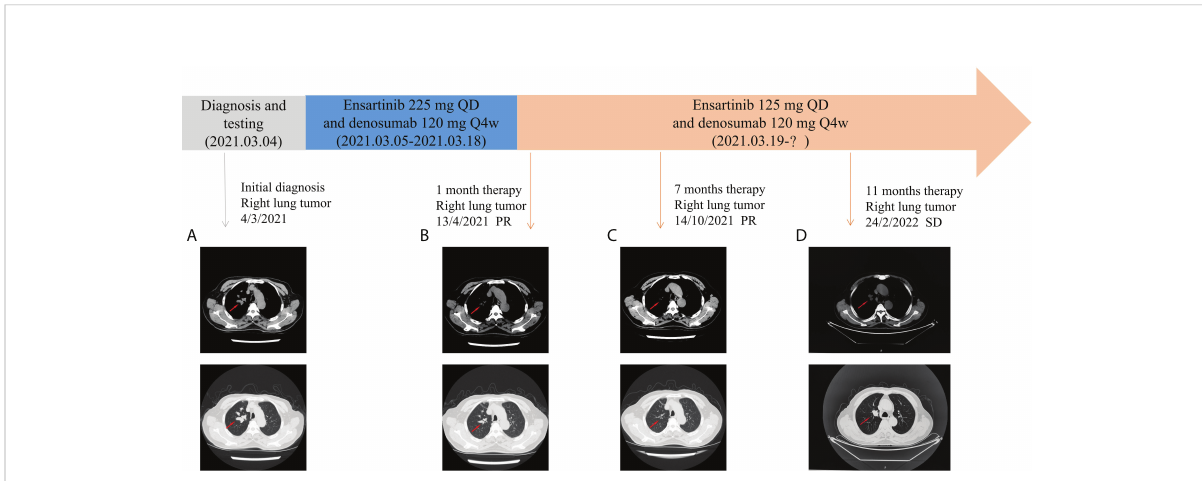
FIGURE 5 Comparison of CT images before and after treatment with ensartinib. (A) Before ensartinib treatment; (B) 1 month after ensartinib treatment; (C) 7 months after ensartinib treatment; and (D) 11 months after ensartinib treatment.